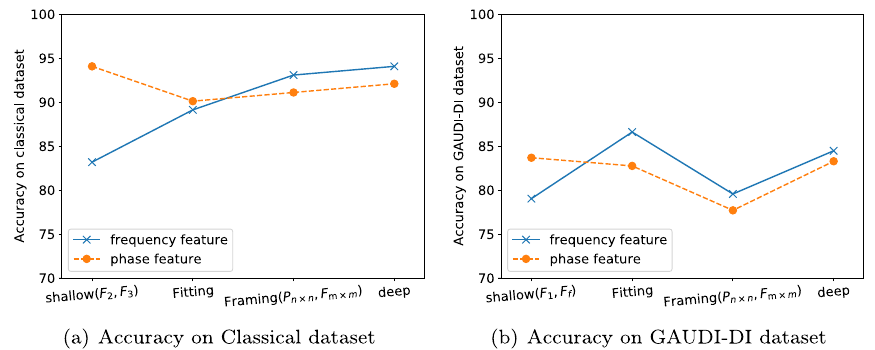
Fig. 4 Accuracy of phase and frequency features, shallow features ( F 1 , F f ), fitting coefficient ( P coe , F coe ), input of the convolutional ( P n n , F m m ), deep phase and frequency × ×